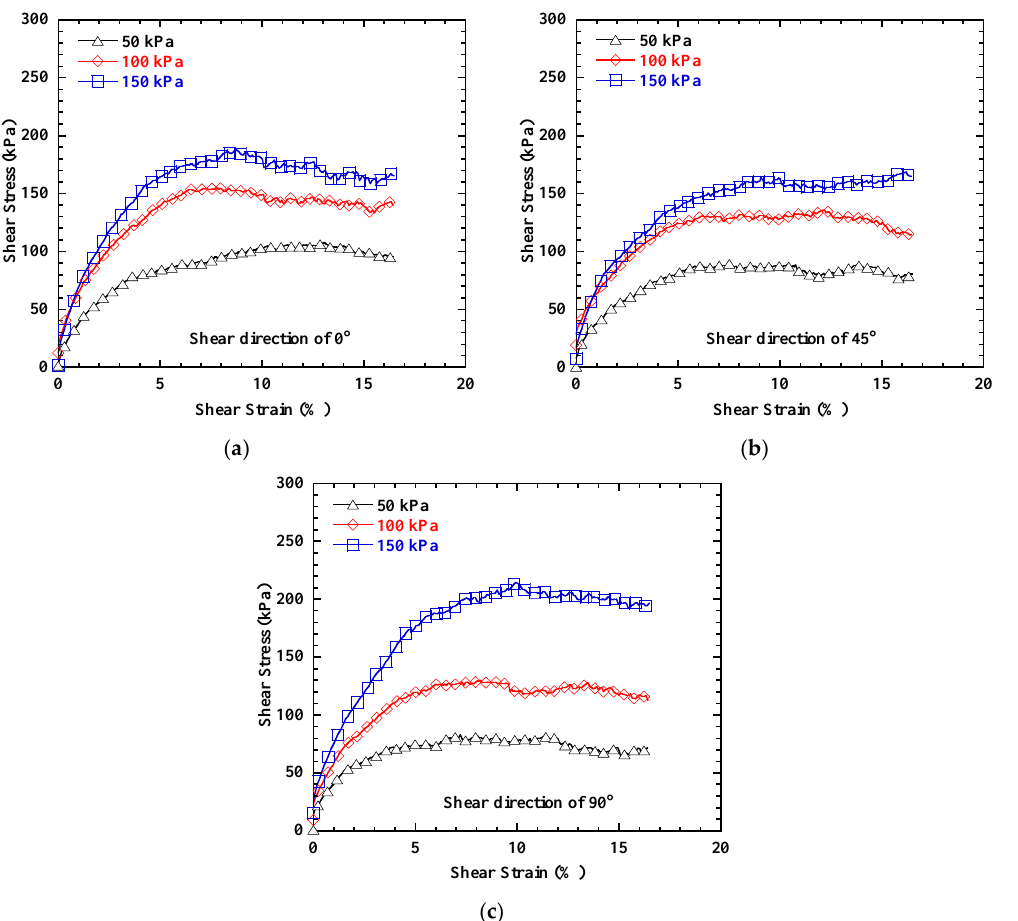
Figure 12. Shear stress–strain curves for gravel–triaxial geogrid (TX150) interfaces. ( a ) Shear direction of 0°, ( b ) shear direction of 45°, ( c ) shear direction of 90°.